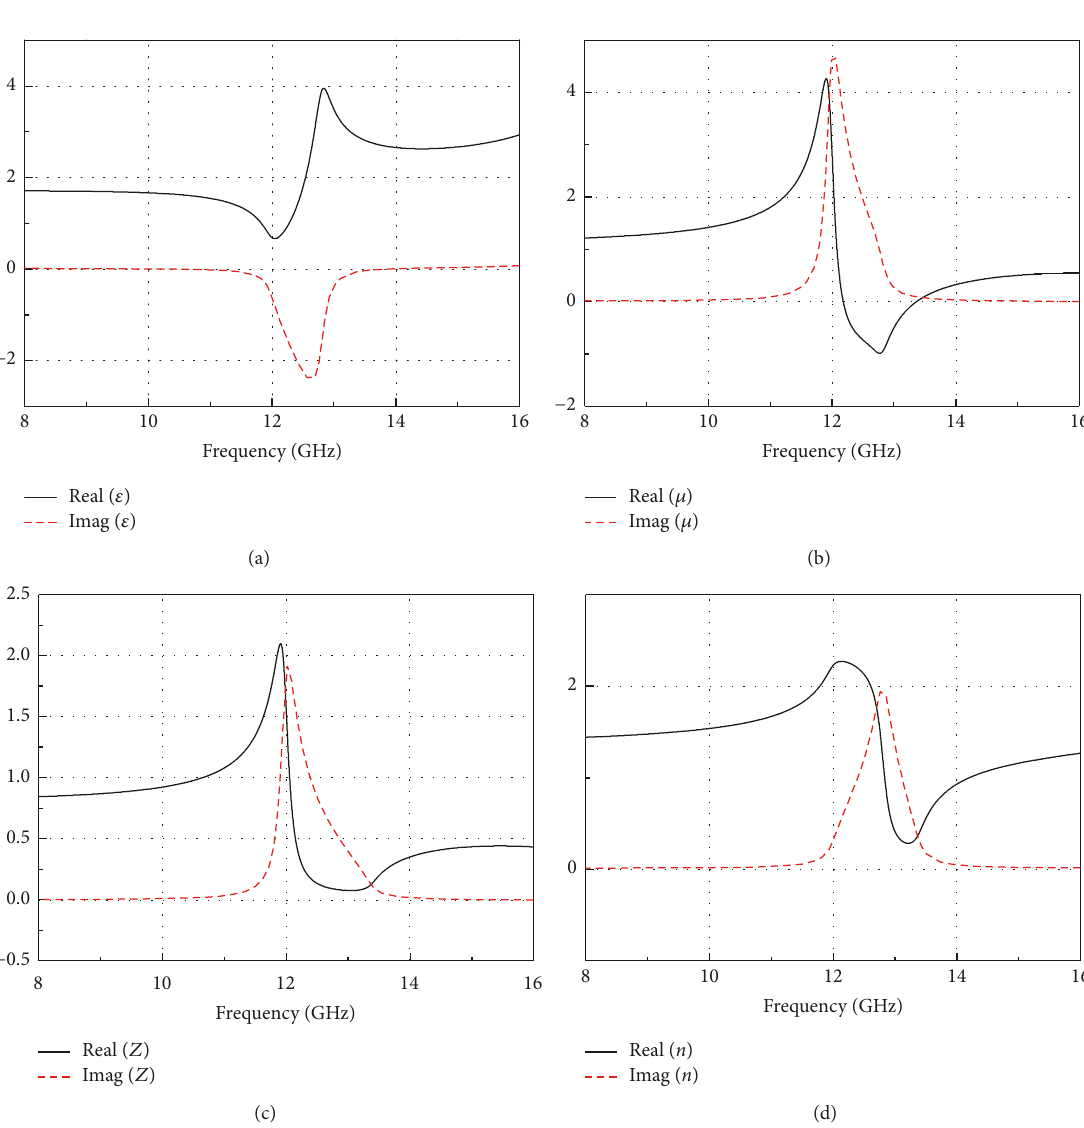
Figure 3: The simulated S parameters.